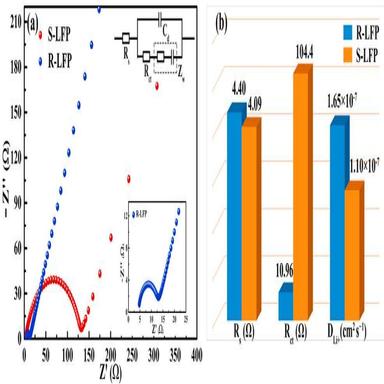
(a) Nyquist plots in the frequency range of 0.01 Hz–100 kHz for S-LFP and R-LFP. (b) The lithium diffusion coefficient of S-LFP and R-LFP.